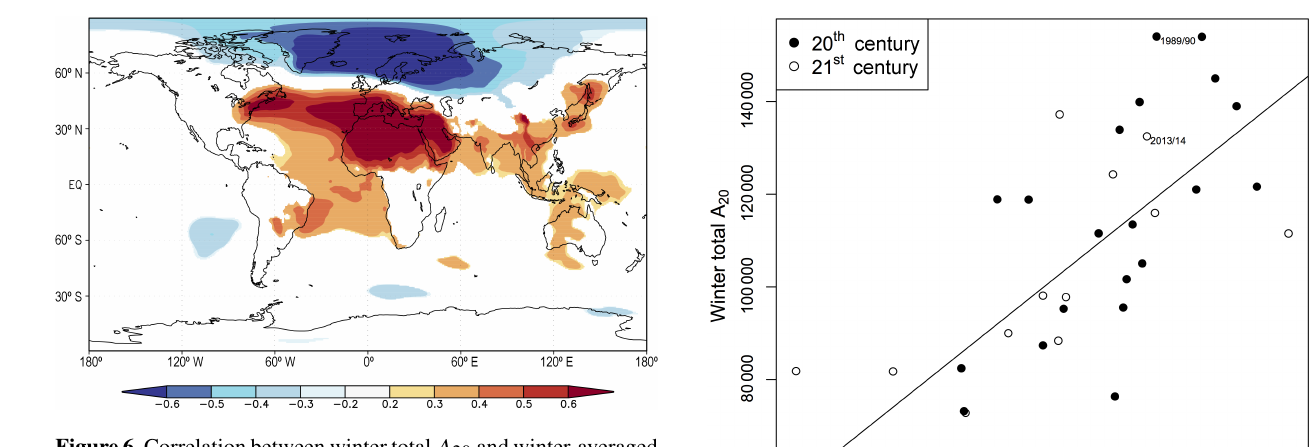
Figure 6. Correlation between winter total A 20 and winter-averaged mean sea-level pressure in each grid cell in the ERA-Interim reanal- ysis for October–March winters 1979/1980–2013/2014.